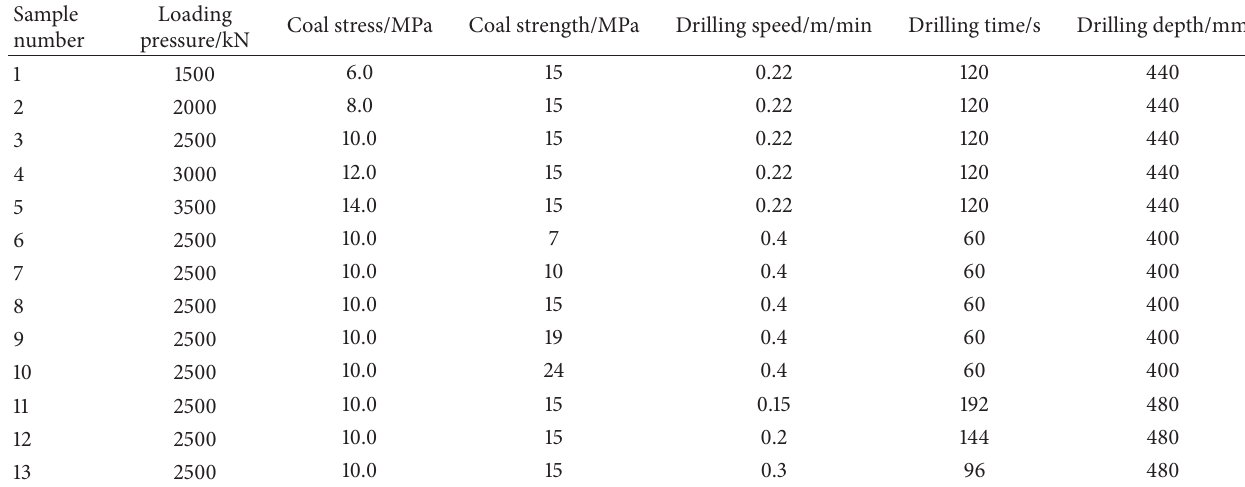
Table 1: Loading and drilling conditions of the